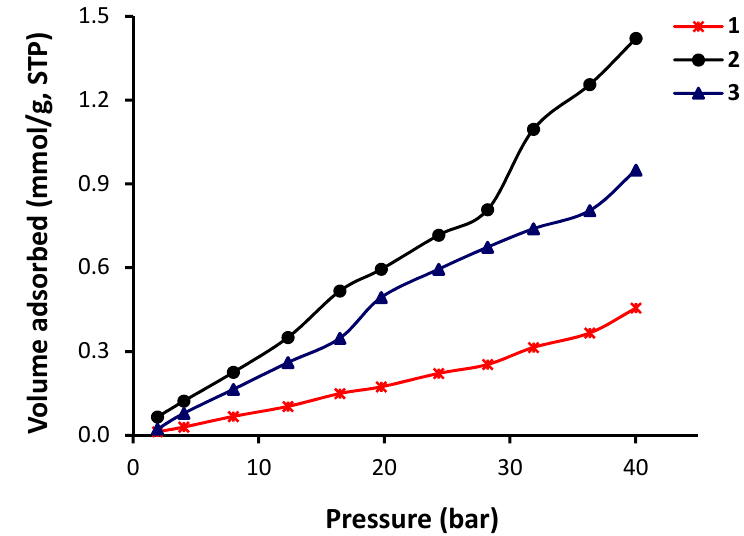
Figure 8. CO 2 adsorption isotherms for polyphosphates 1 – 3 . Table 4. CO 2 adsorption capacities of 1 – 3 at 323 K and 40 bar.